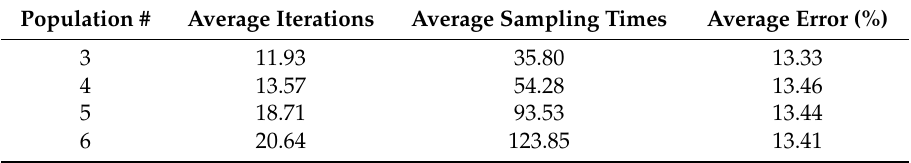
Table 6. Simulation results of the NaFA with different population numbers under the 10 patterns.